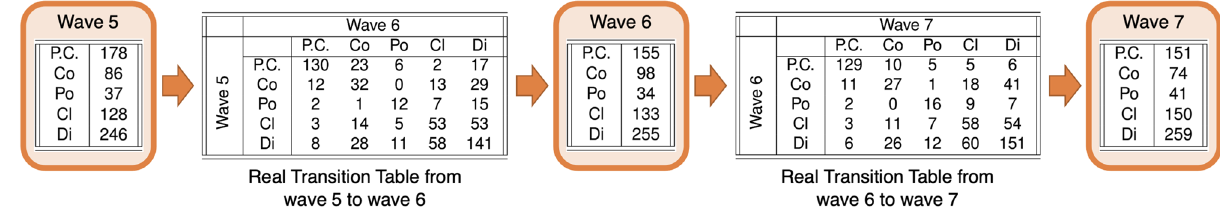
Figure 3. Real transition tables: The 675 real opinion distributions emerging from the World Values Survey 27–29 waves 5, 6, and 7 are qualitatively classified as perfect consensus (P.C.), consensus (Co), polarization (Po), clustering (Cl), and dissensus (Di) in the orange panels. The transition tables show the qualitative evolution of opinion distributions between these waves, highlighting how each qualitative category of opinion distributions could evolve into the various other